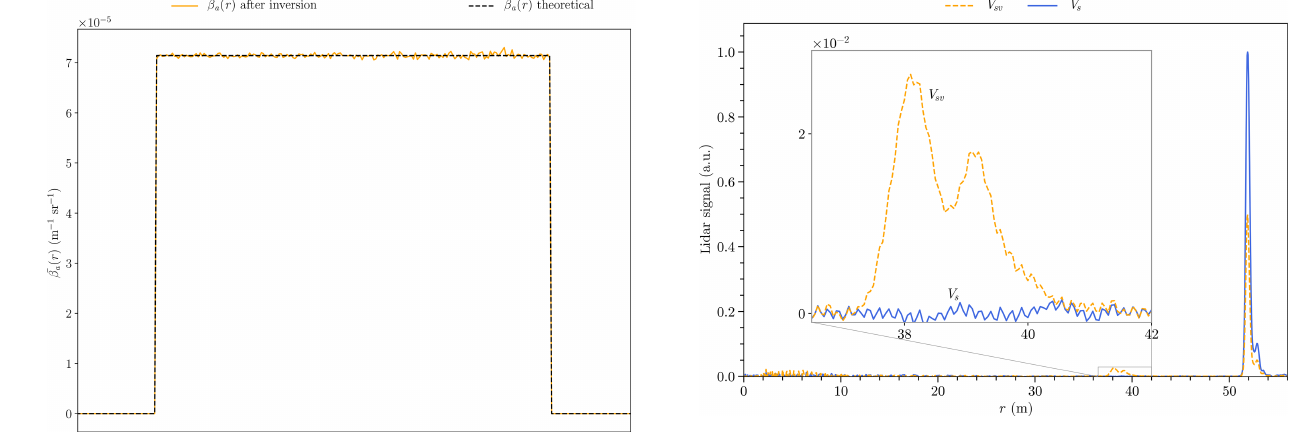
Figure 9. Lidar measurements of the experimental setup. In blue, (orange) the lidar signal in the absence (presence) of the oil-fog plume under